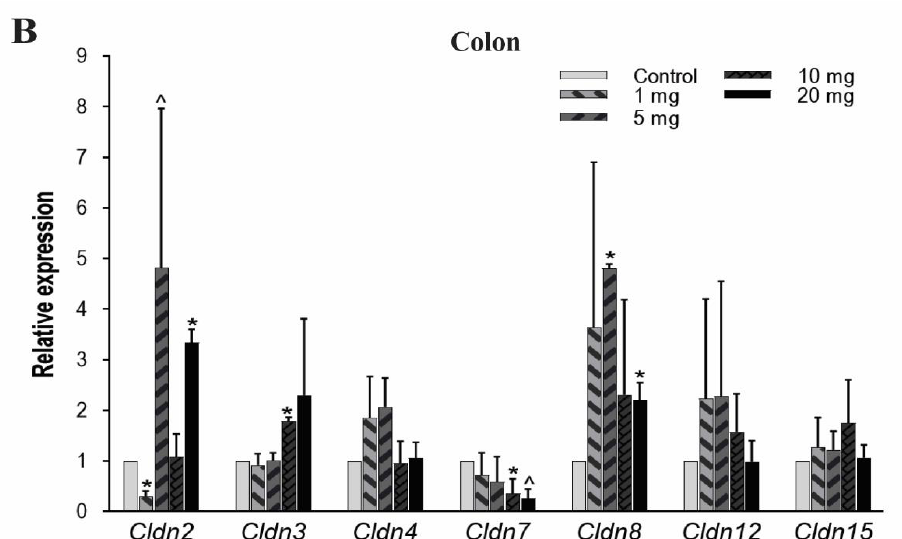
Figure 3. Effect of PFOA on the expression levels of tight junction gene Cldn in intestinal tissues of CD1 mice. Mice were treated with control (0.5% Tween-20 in water) or 1–20 mg/kg/day PFOA for 10 days. ( A ) Change in the mRNA expression level of Cldn2, Cldn3, Cldn4, Cldn7, Cldn8, Cldn12, and Cldn15 genes in the small intestine; ( B ) change in the mRNA expression level of Cldn2, Cldn3, Cldn4, Cldn7, Cldn8, Cldn12, and Cldn15 genes in the colon. Statistical values were considered significant at p -value ≤ 0.05 (denoted by “*”) and less significant at p -value > 0.05 but < 0.1 (denoted by “^”) reported from two-tailed tests.